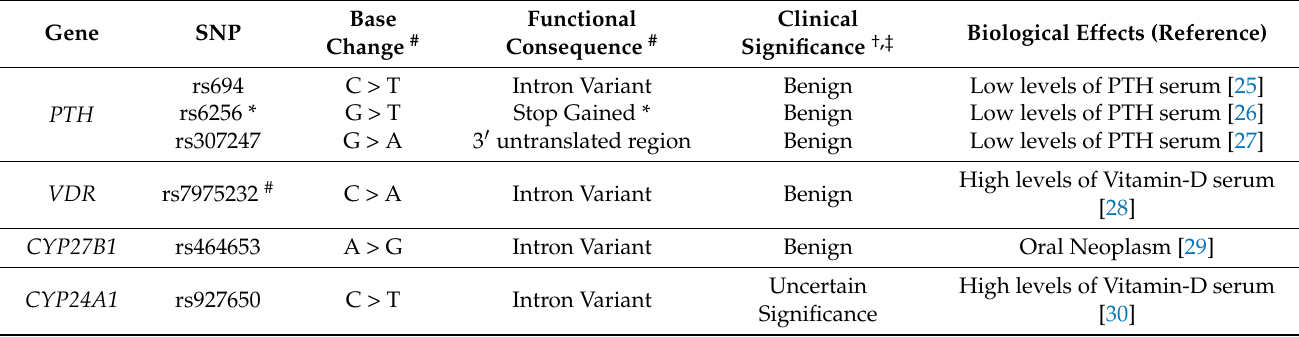
Table 1. Characteristics of the studied